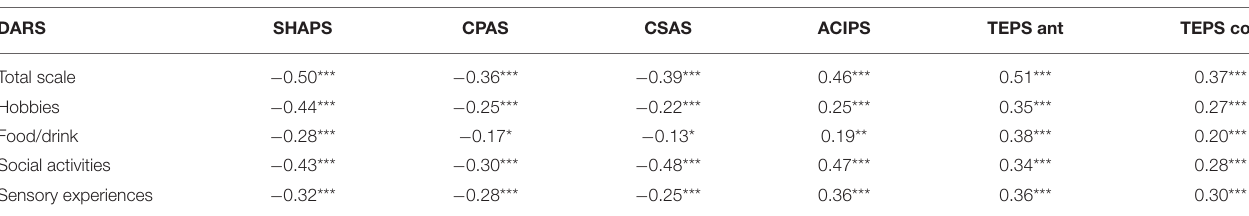
TABLE 3 | Correlations between the DARS and other anhedonia scales.